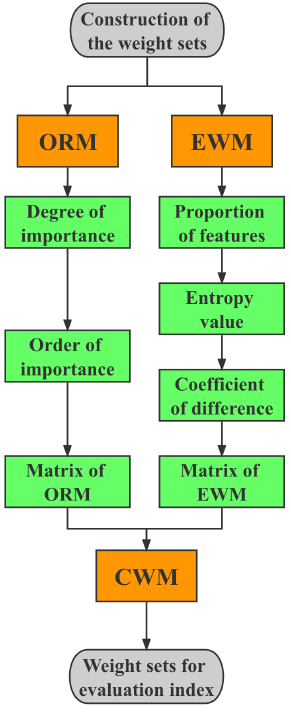
Figure 2. Steps of construction for the weight